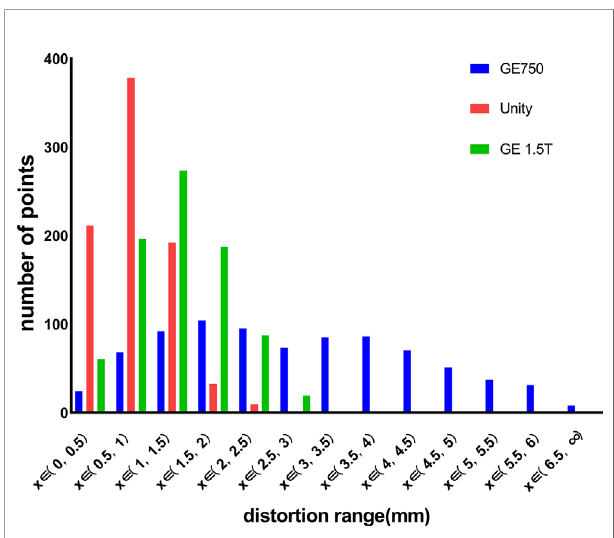
FIGURE 4 | Distribution range of the distortion points for GE 750, Unity, and the GE Signa